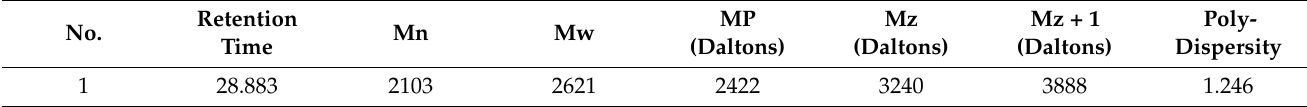
Table 1. GPC of the prepared polyethylene sebacate (PES).